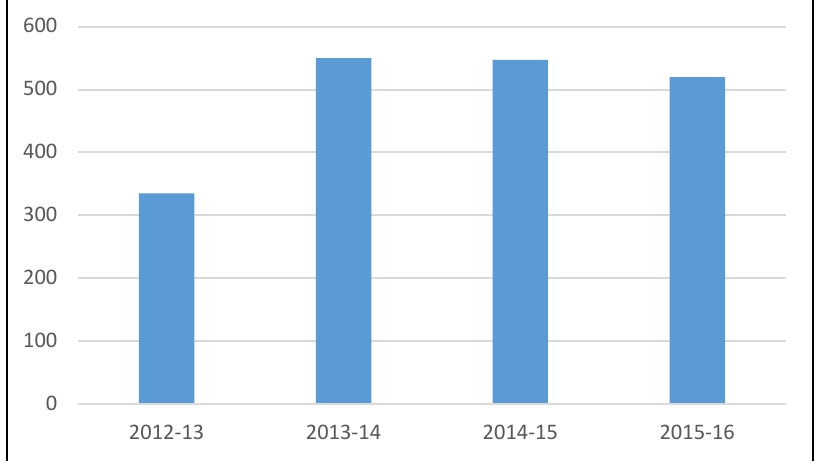
Figure 1 RefWorks Current Users, Defined as Accounts Used Sometime in the Last Two Years.